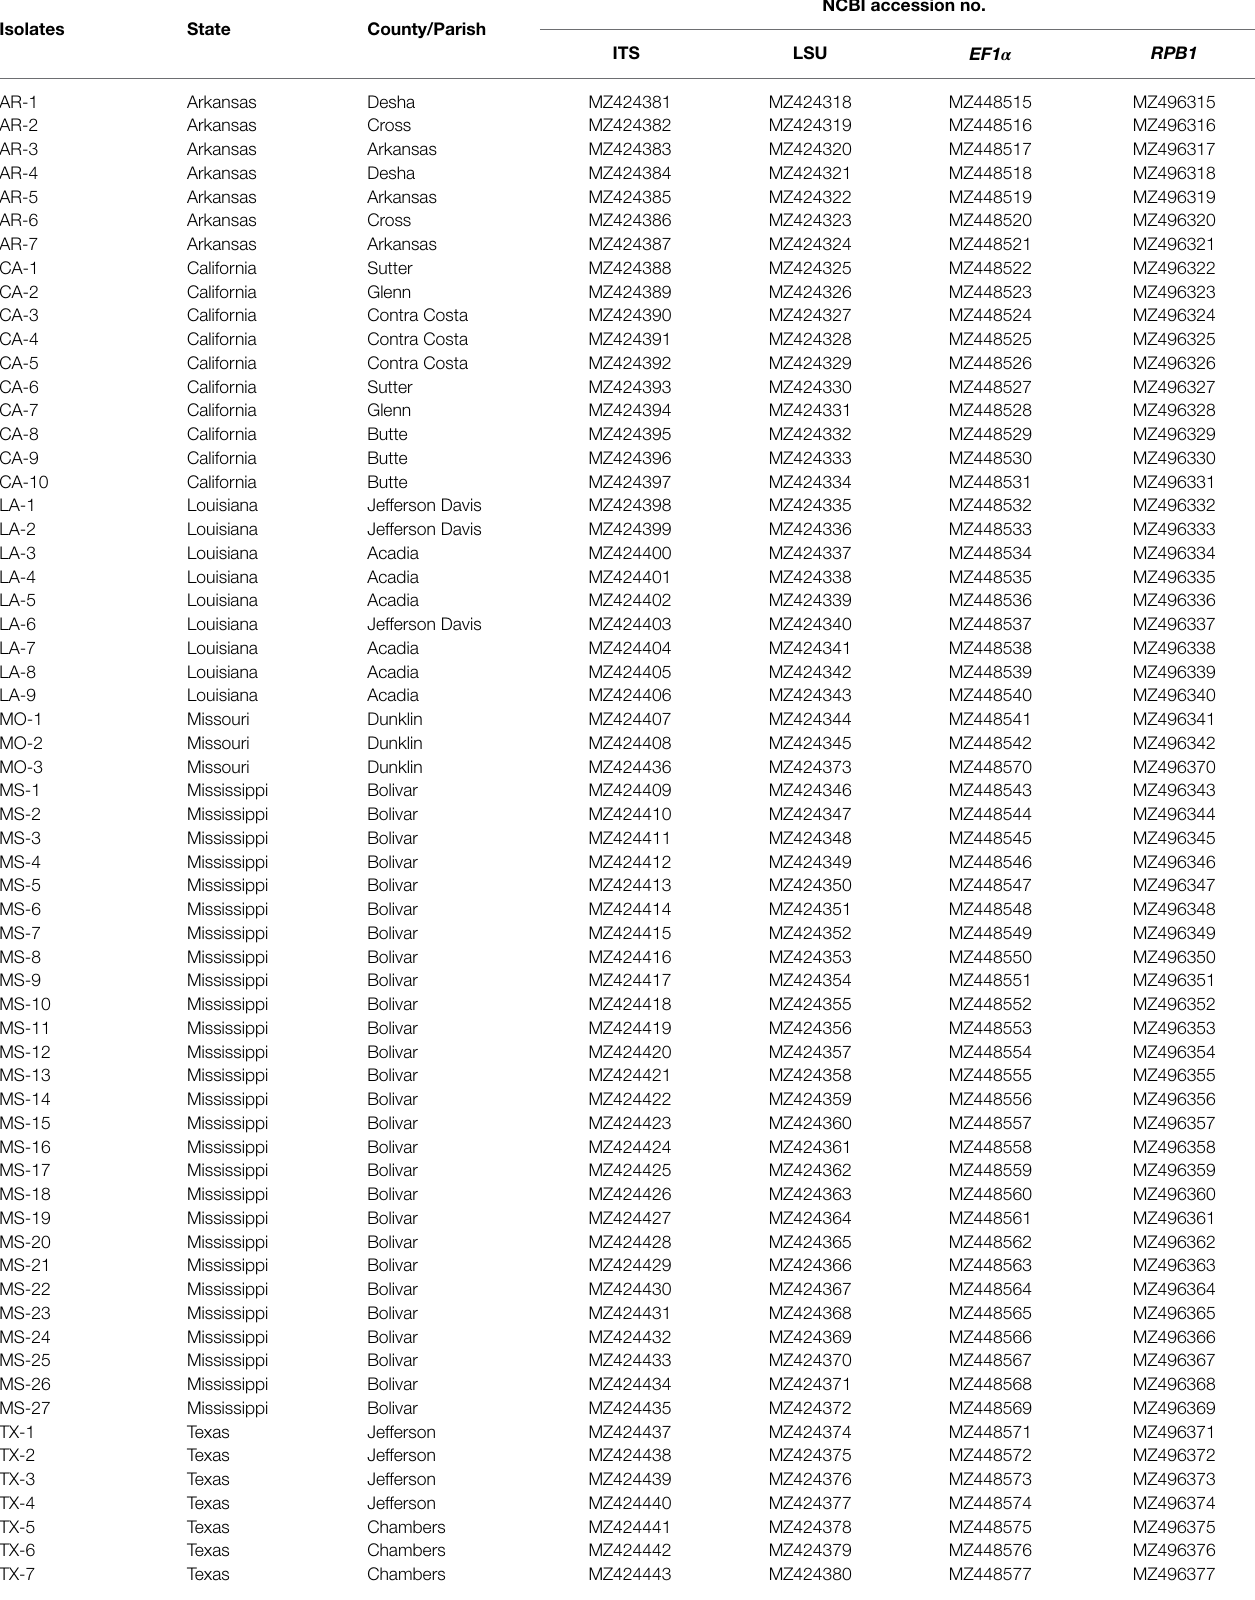
TABLE 1 | Geographic origin and NCBI accession number of 63 isolates of Tilletia horrida sequenced in this study.